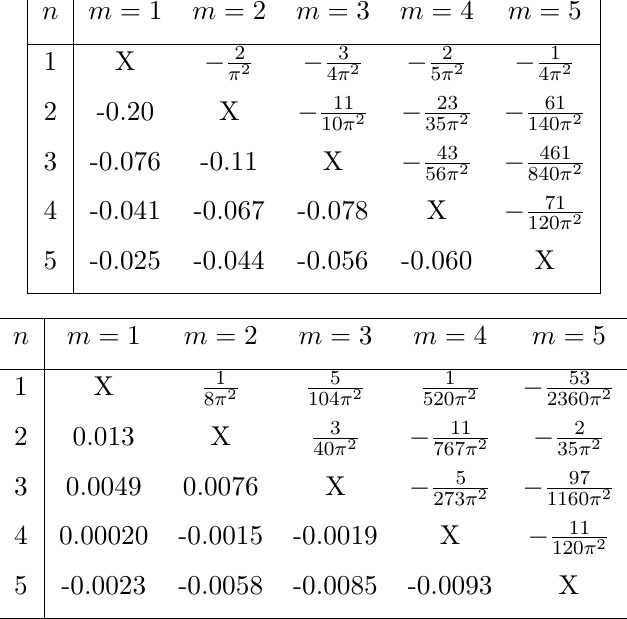
Table 2 . Sectional curvatures K ( u, v ) at f ( σ ) = σ for c = 1 , h = 0 (top) and c = h = 1 (bottom) for small values of m, n . Note that (5.7) is not symmetric under exchanging m ↔ n because it was simplified assuming m > n in order to get rid of terms like sign ( m − n ) , but the values of K ( u, v ) are of course symmetric. We make use of that symmetry, for the convenience of the reader, to display both exact values above the diagonal and approximate decimal values below the diagonal. While in the h = 0 case all sectional curvatures are negative, for large enough values h a finite number of the sectional curvatures will be positive. Only in the limit h/c → ∞ will all the curvatures become positive, see also table 3.